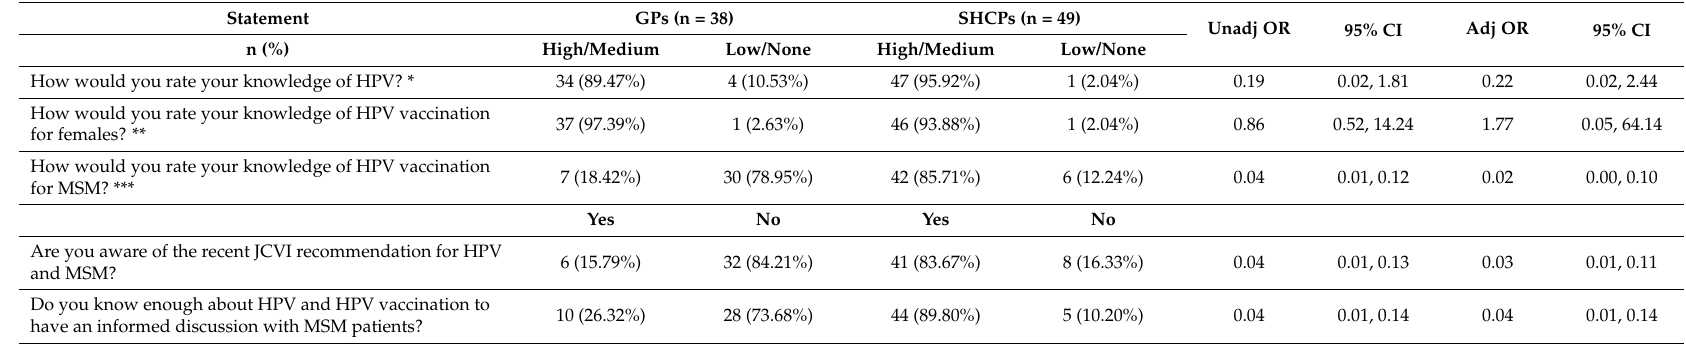
Table 2. GPs and SHCPs knowledge regarding HPV vaccination.